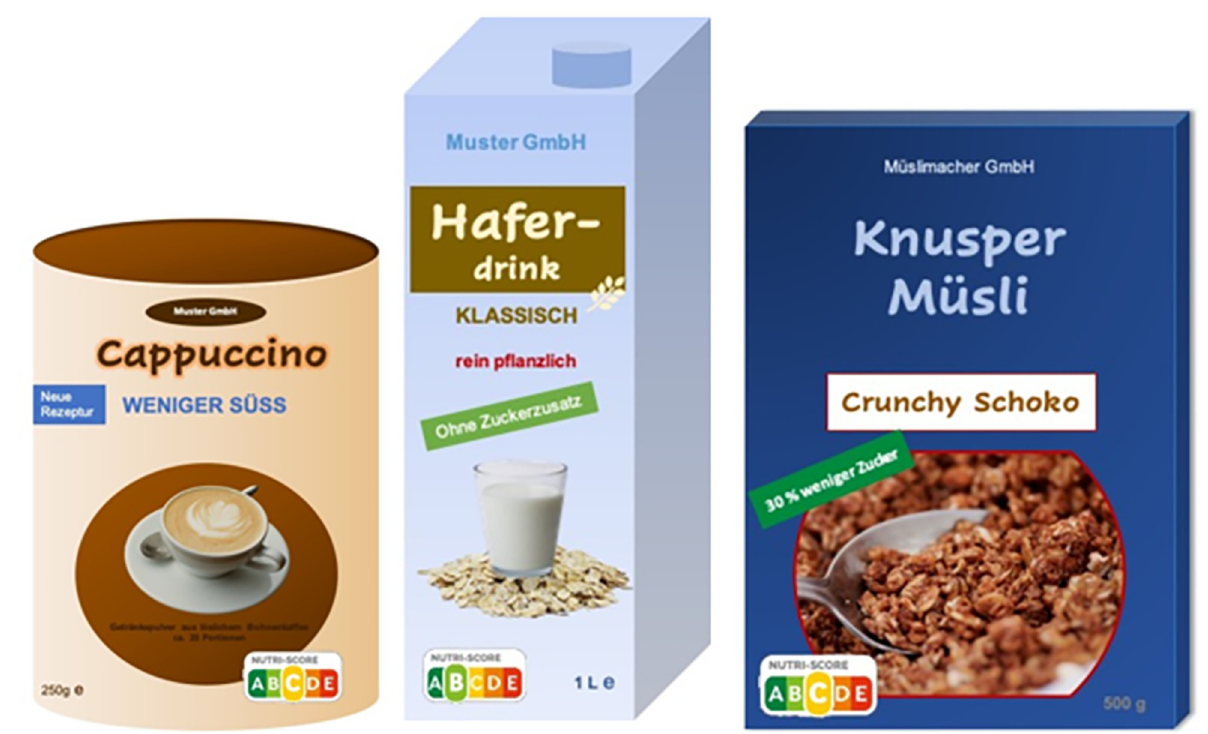
Fig 3. Product examples with the three sweet claim variations and the Nutri-Score.